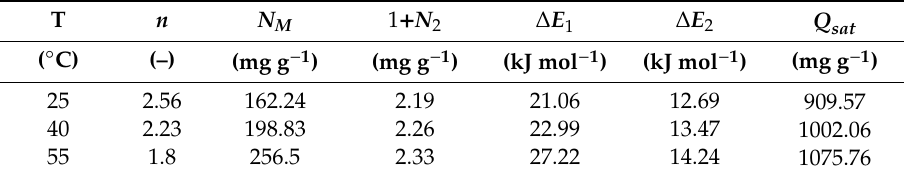
Figure 7. Evolution of statistical physics parameters ( a ) n , ( b ) N M , ( c ) Q sat and ( d ) ∆𝐸 as a function of temperature for the CV adsorption on MNP/CTAB–EC composite Table 6. Steric and energetic parameters of the multilayer layer model for the adsorption of CV on MNP/CTAB-EC composite.